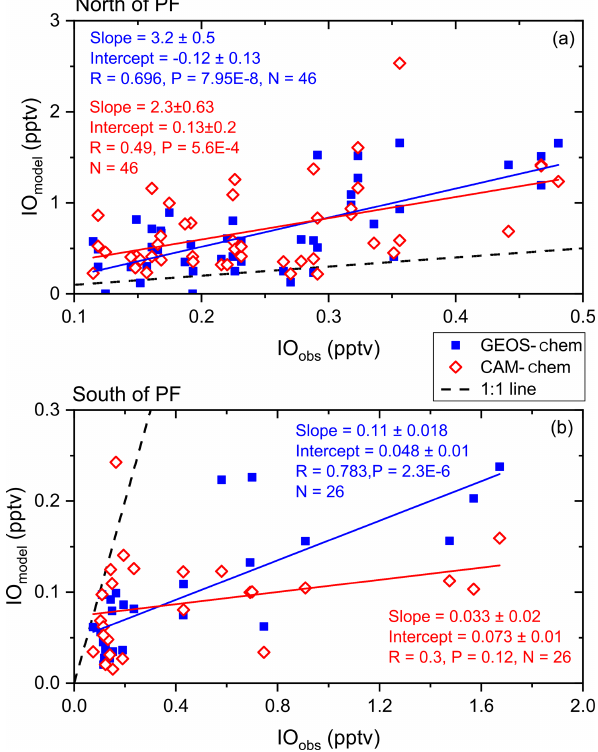
Figure 10. Linear fit of daily averages of modelled surface io- dine monoxide (IO) output ( y axis) from GEOS-Chem (filled blue squares) and CAM-Chem (unfilled red diamonds) against observed IO ( x axis) for the ISOE-8, IIOE-2, and ISOE-9 campaigns. Panel (a) includes linear fits of both GEOS-Chem and CAM-Chem for IO detected to the north of the polar front, and panel (b) shows the same for the region south of the polar front. Two data points in (a) at 41 and 43 ◦ S are removed due to large differences between obser- vations and modelled